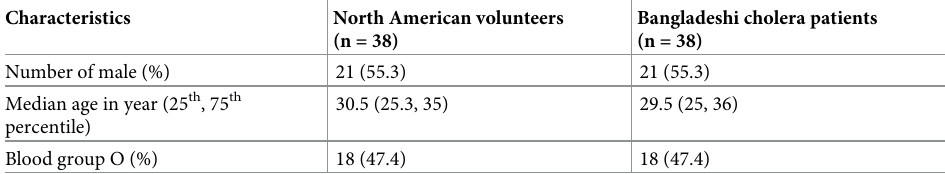
Table 1. Characteristics of North American experimentally-infected volunteers and Bangladeshi naturally- infected cholera